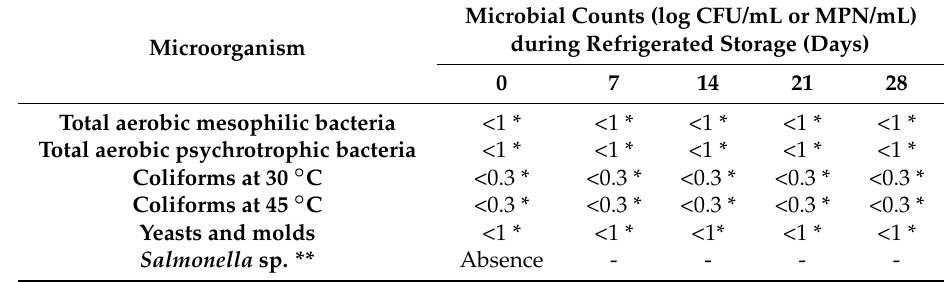
Table 2. Microbiological characterization of probiotic functional carbonated beverage immediately after manufacture and during refrigerated storage.